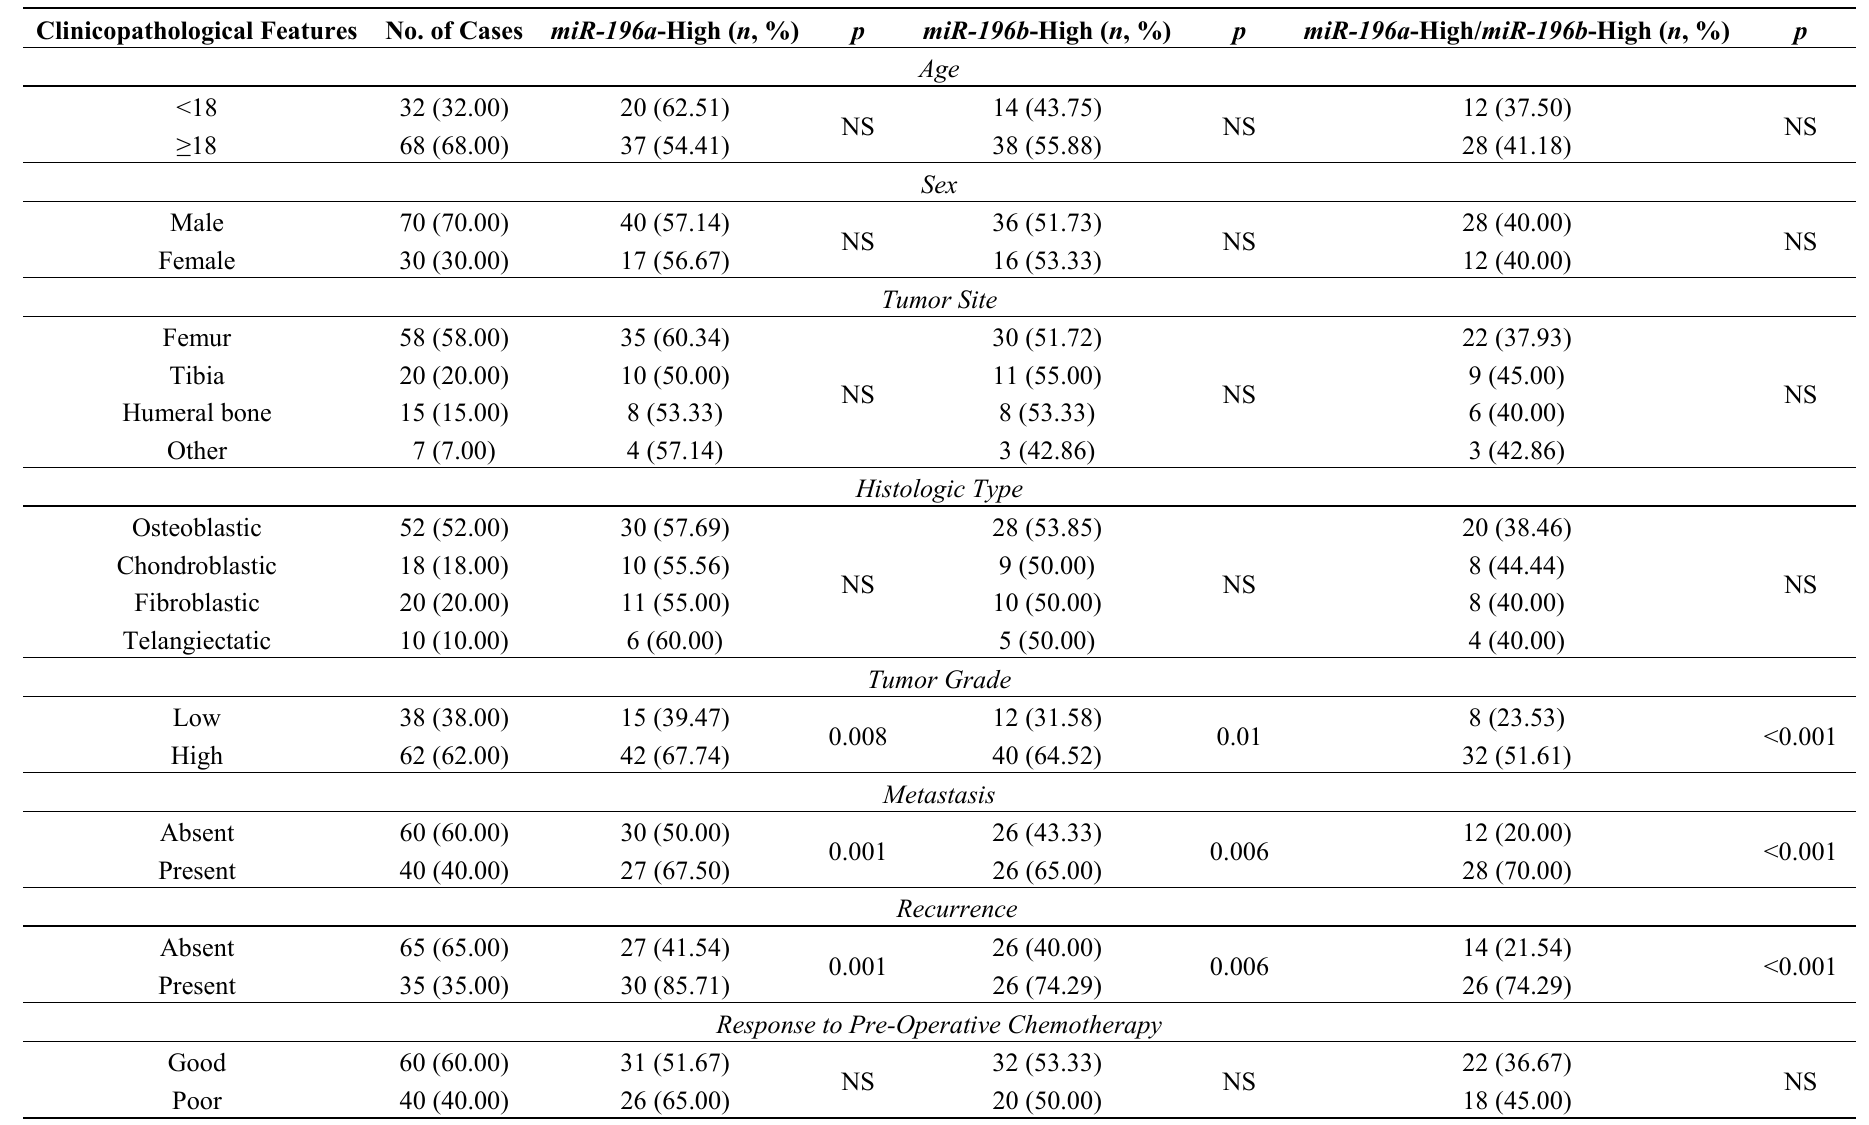
Table 1. Association of serum miR-196a and miR-196b levels with clinicopathological features of osteosarcoma. Clinicopathological